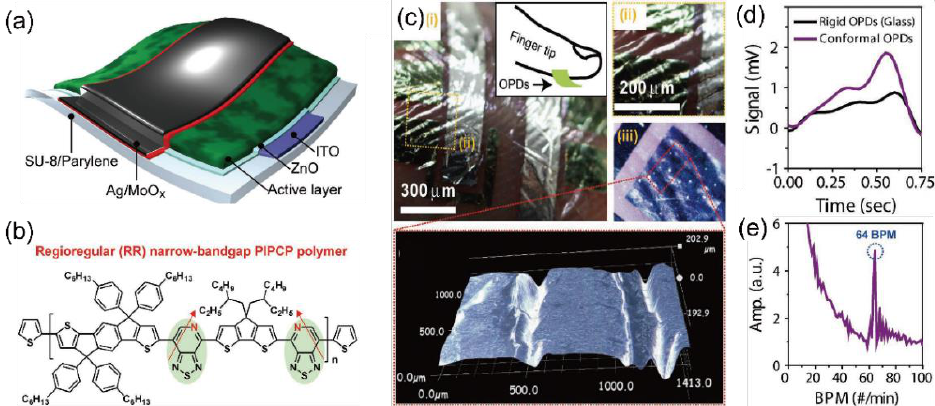
Figure 11. ( a ) Schematic device structure of the near-IR photoresponsive ultra-flexible organic photodetector. The devices are fabricated on polymeric substrates. After fabrication, the devices are passivated with a 1 μm-thick parylene layer. ( b ) Chemical structure of PIPCP. The regioregularity of the PIPCP polymer is highlighted with a red arrow, indicating the orientation of asymmetric pyridyl-[1–3]thiadiazole (PT) unit. ( c ) (i, left top image) Photograph of fingerprint-conformal near-IR photodetectors and inset indicates the position of the skin-conformal near-IR photodetector on the finger (ii, right top image) enlarged image of (i), and (iii, right bottom image) microscope image of top silver electrode and skin surface, indicating high skin-conformability. (bottom) 3D microscope image of ultra-flexible near-IR organic detectors on the surface of a human index fingertip. ( d ) Comparison of the output signal between the glass reference (black) and the skin-conformal near-IR photoplethysmogram sensor (purple) wrapped over a fingertip with a 99% blood oxygenation level. ( e ) Beats per minute (BPM) analyzed from measured output signals using fast Fourier transform (FFT) signal processing (64 BPM is the representative heart rate in the acceptable range for adults aged 15–30 years). Adapted with permission from [37], Wiley, 2018.